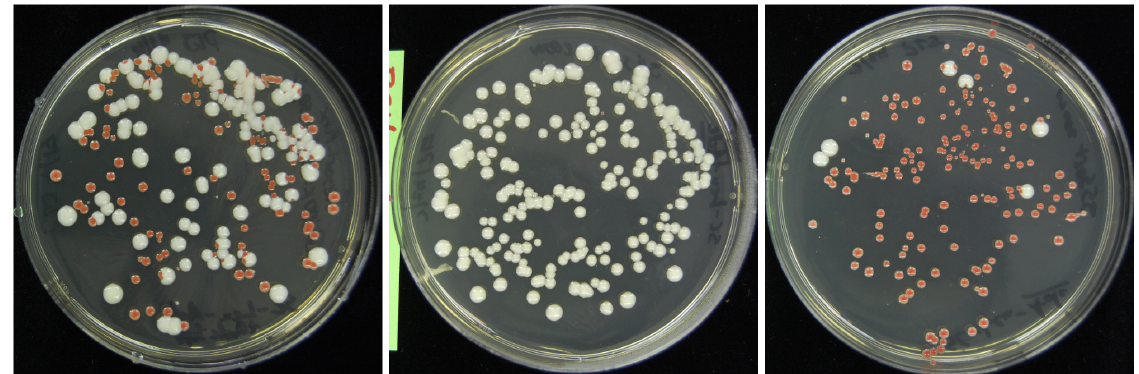
Figure 4. Sorting yeast cells by fluorescence lifetime. We plated cells from pre-sort mixture and sorts on SC-leu- with 0.001% adenine, and photographed colonies after 48 hours. Left panel, pre sort mixture. Middle panel: sorted for long lifetime, enriched for white (BSY034, TFP) colonies. Right panel, sorted for shortened lifetime, enriched for red (BSY035, dCit-TFP) colonies. For each of three different trials we sorted three or four plates each of TFP and dCit-TFP strains. The plates here are representative examples.